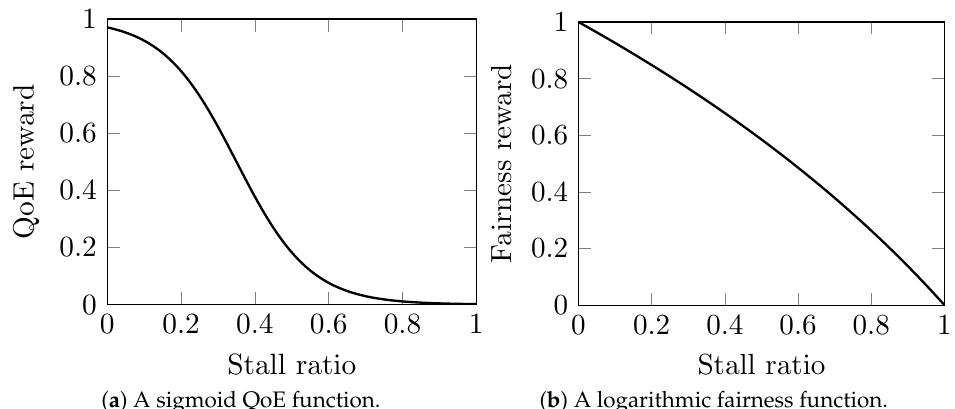
Figure 4. The reward functions used to evaluate the performances of different bandwidth assignment algorithms. The QoE function is defined by Equation (16), and the fairness function is defined by Equation (17).